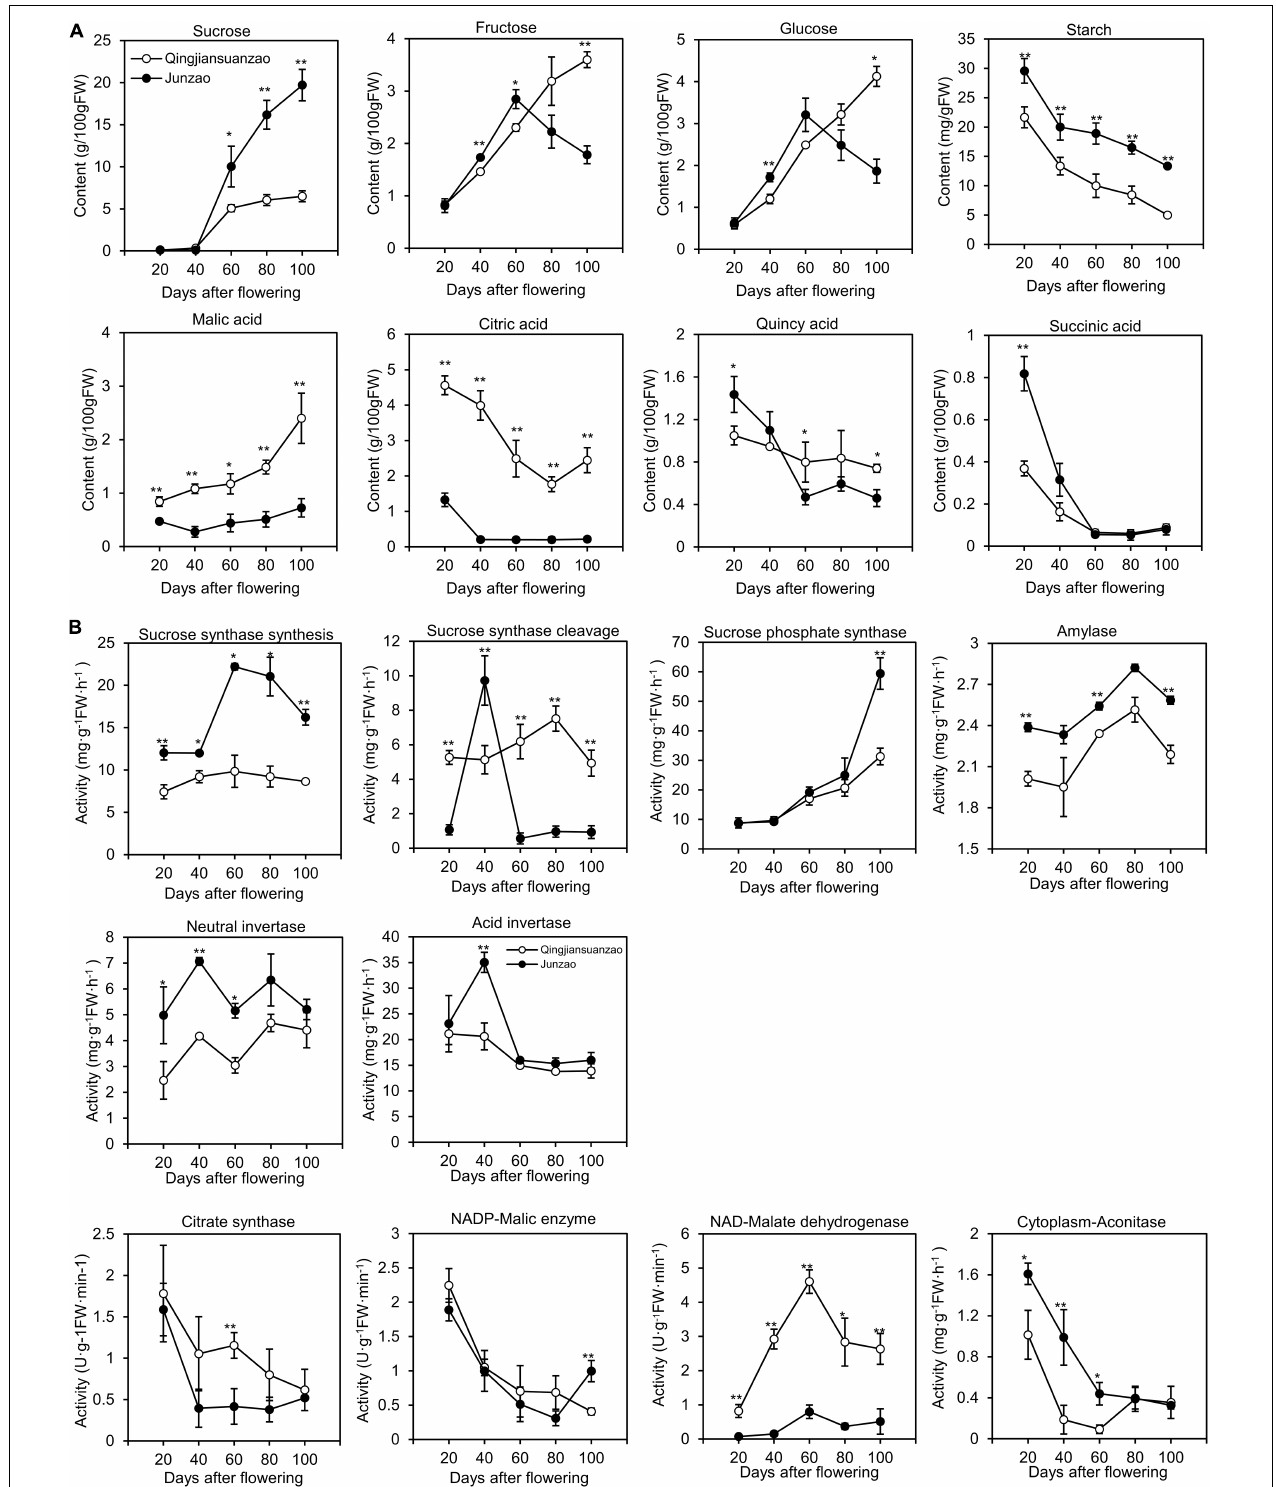
FIGURE 3 | Dynamics of sugar, organic acids, and related enzyme activities during fruit development and ripening. (A) Changes in contents of sucrose, fructose, glucose, malic acid, citric acid, quincy acid, and succinic acid during fruit development in ‘Junzao’ and ‘Qingjiansuanzao’; (B) Activity changes of key enzymes involved in sugar and organic acid metabolism. Values are means of three biological replicates ± SD. * and ** indicate significant differences between the two accessions at levels p < 0.05 and p < 0.01 by t -test, respectively.